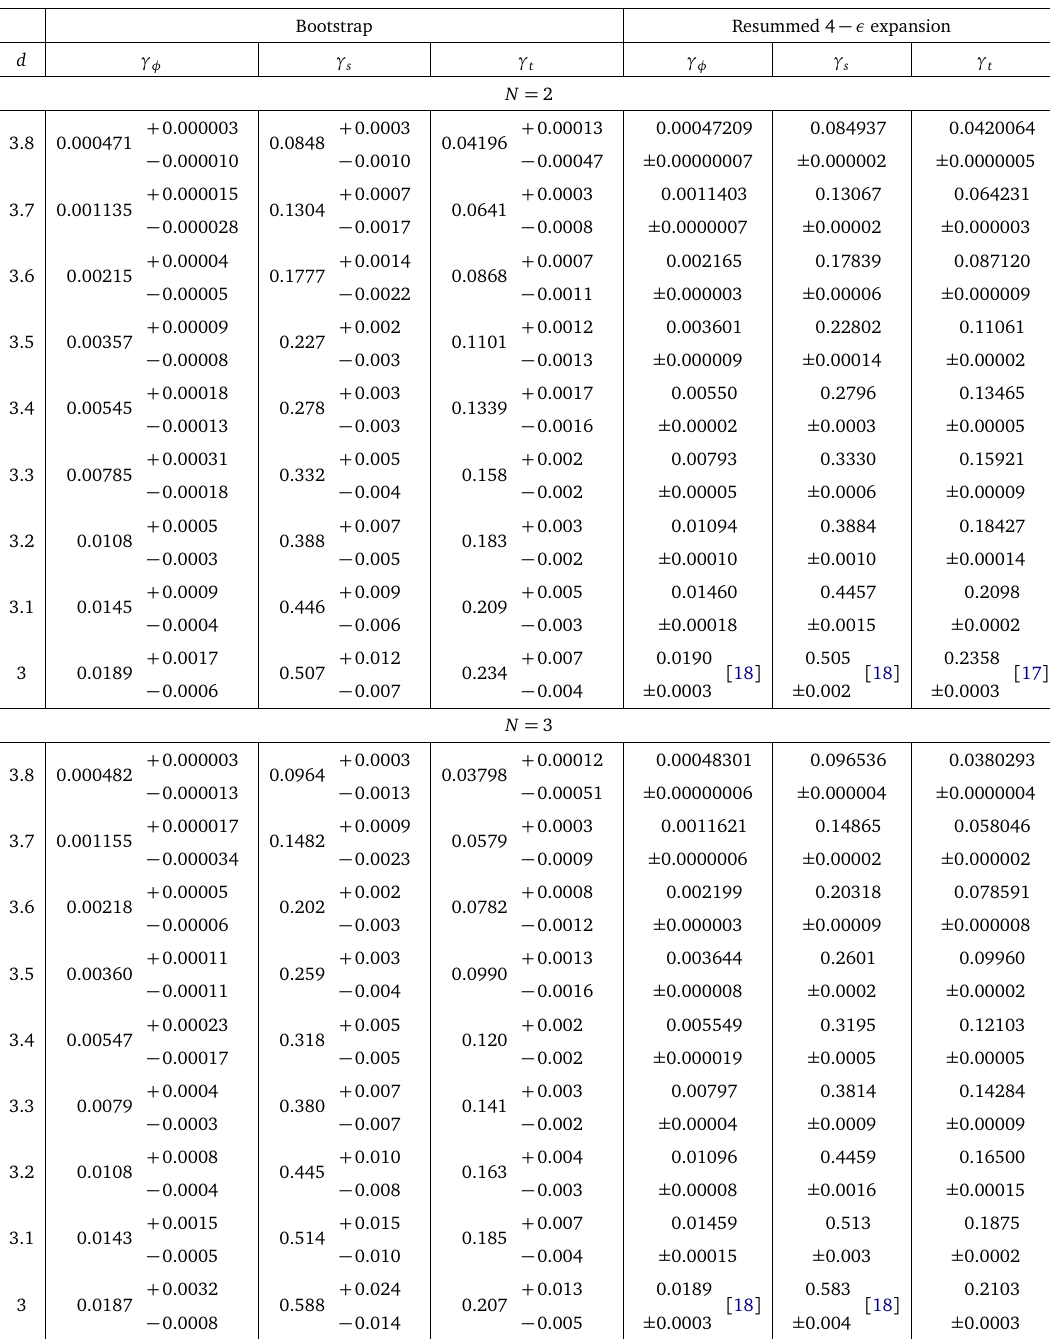
Table 1: Comparison of bootstrap and ε -expansion results for the anomalous dimen- sions of the first scalar O ( N ) vector, scalar singlet and scalar traceless-symmetric 2-index tensor, for N = 2,3 and d ∈ [ 3,4 ] . Bootstrap results are given as the values at the transformed navigator minimum, with uncertainties given by the distance to the maximal and minimal values determined by the Constrained BFGS